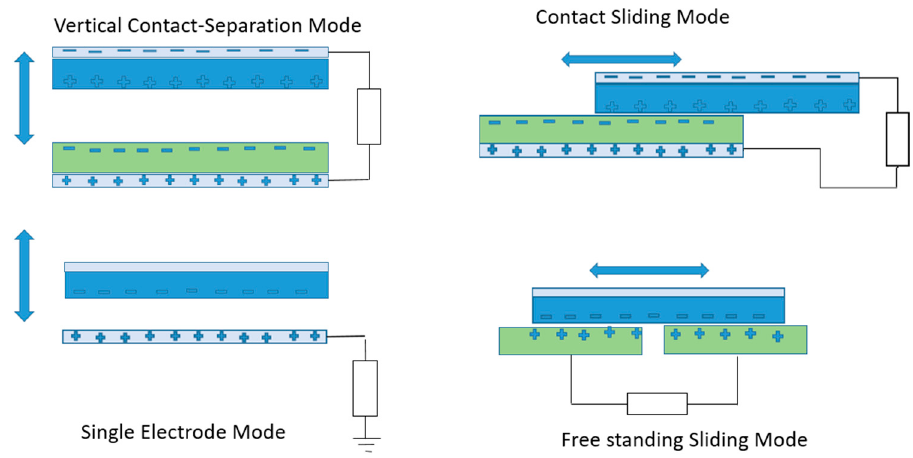
Figure 1. Four fundamental modes of electrostatic devices [15].